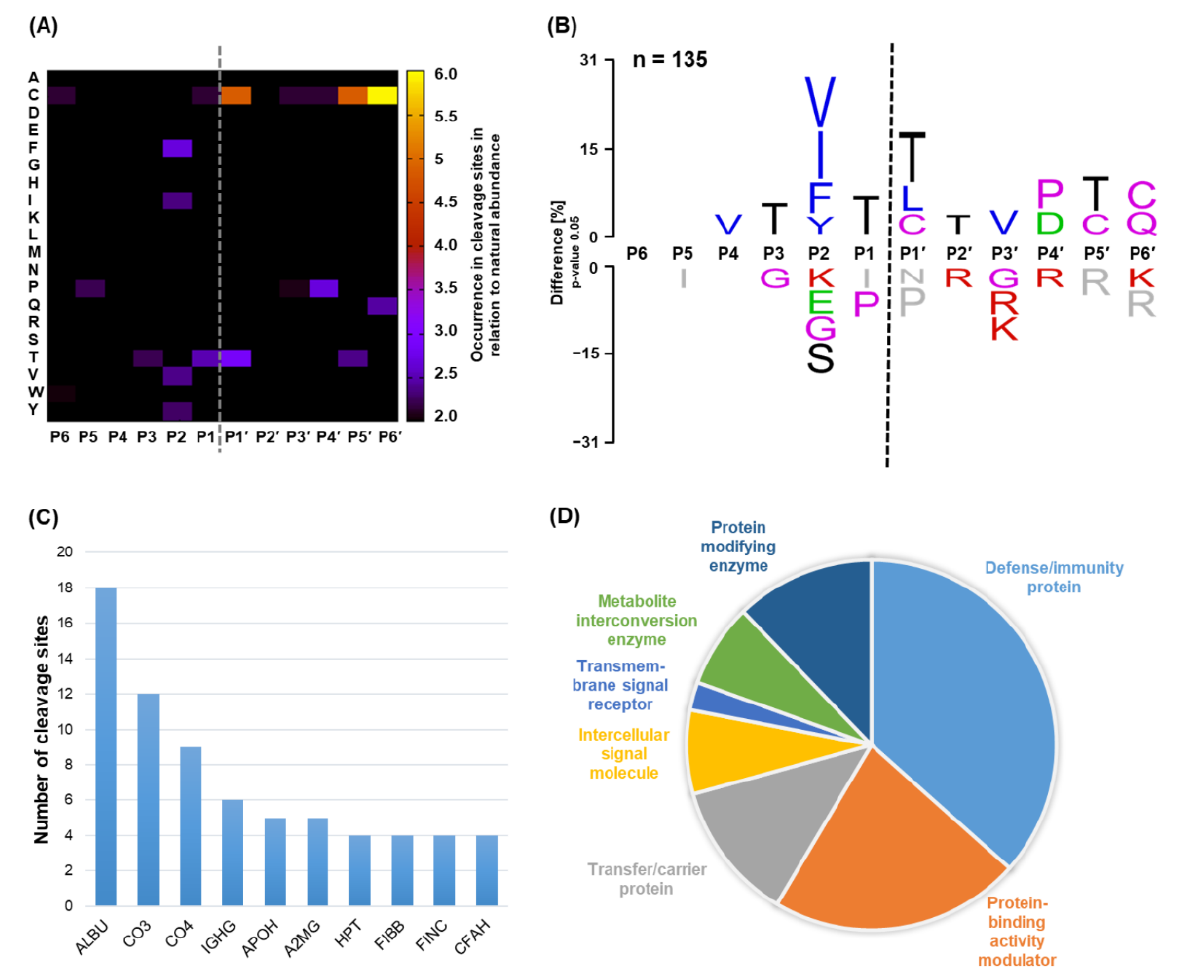
Figure 4. Identification of cleavage sites in intact proteins derived from plasma samples. A total of 135 cleavage sites were consistently identified by the N-terminomics workflow in plasma samples of two individual donors. Analysis was conducted based on cleavage sites that were combined from peptides identified after subsequent tryptic and GluC digestion, respectively. Based on these data, the heatmap in panel ( A ) depicts the fold-change in occurrence of specific amino acids at certain positions in the substrate in relation to their natural abundance. ( B ) Respective sequence logo demonstrating the difference in percent of amino acids at specific positions in prime and non-prime sites ranging from P6 to P6 ′ . The amino acid color code is defined in the caption of Figure 2. ( C ) Top 10 proteins (UniProt abbreviations) in plasma ranked after the number of SpeB cleavage sites identified. ( D ) Overview of molecular functions terms (gene ontology) assigned to proteins that were cleaved by SpeB, illustrated by a pie chart.